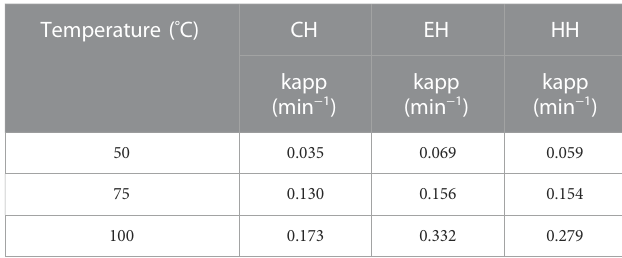
TABLE 2 Summary of the rate constant (Kapp) at different temperatures using CH, EH, and HH. Condition [CL]:[FeCl 3 ] =